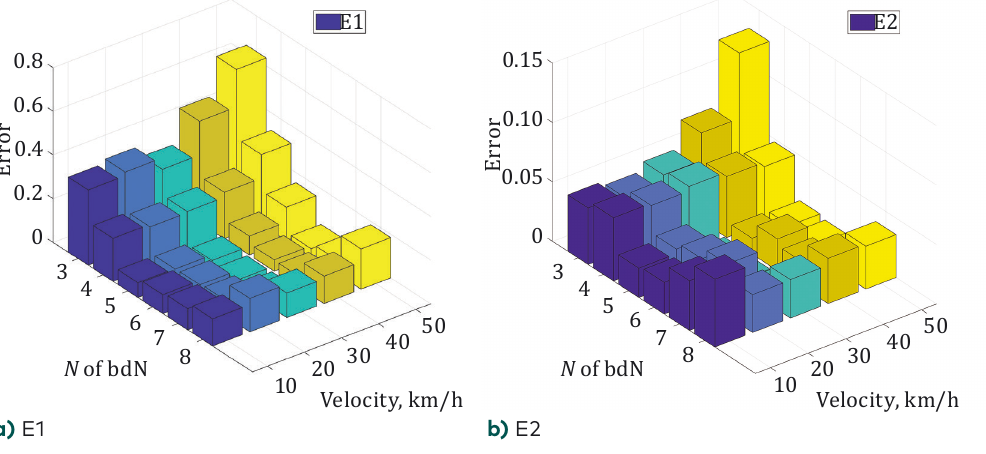
Figure 12. Errors with different velocities and